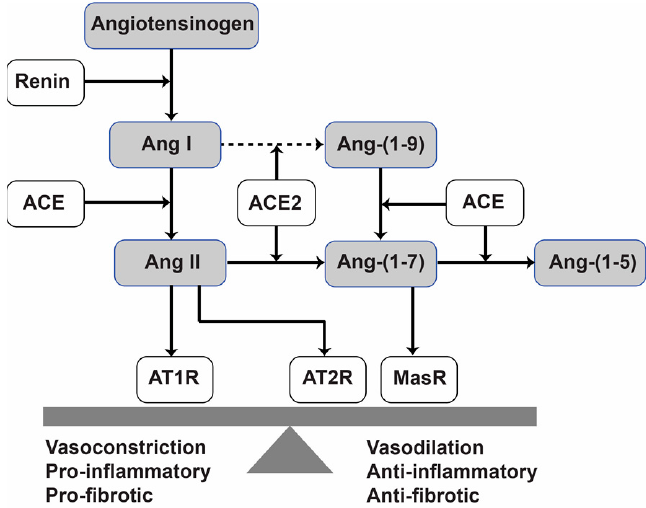
Figure 1. Schematic overview of the RAS. Ang—angiotensin, ACE—angiotensin-converting enzyme, ACE2—angiotensin-converting enzyme 2, MasR—Mas receptor, AT1R—angiotensin II type 1 receptor, AT2R—angiotensin II type 2 receptor.